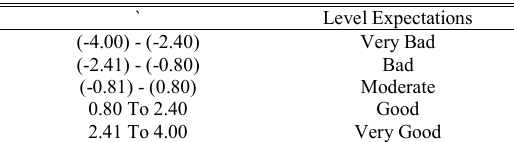
TABLE 1. C RITERIA FOR A SSESSMENT S ERVICE Q